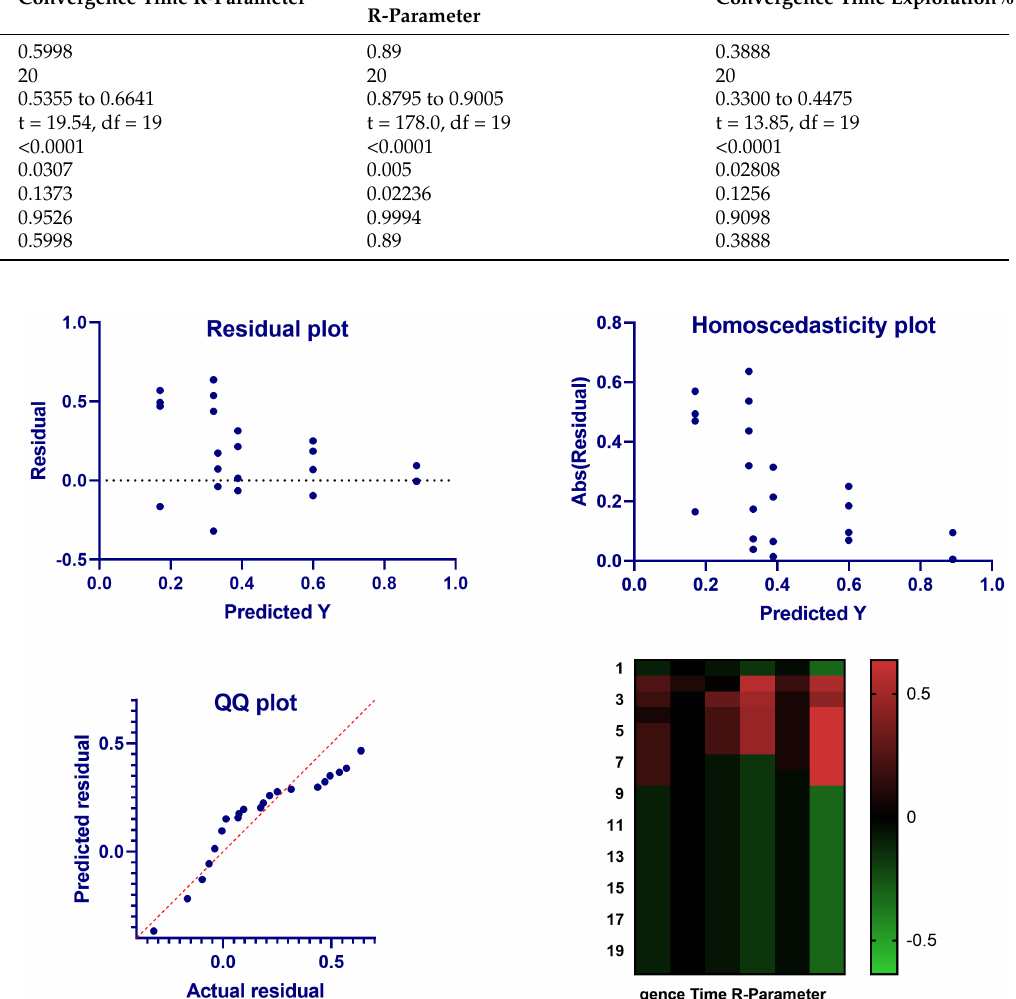
Figure 11. Visualizing the ANOVA test results applied to the sensitivity analysis